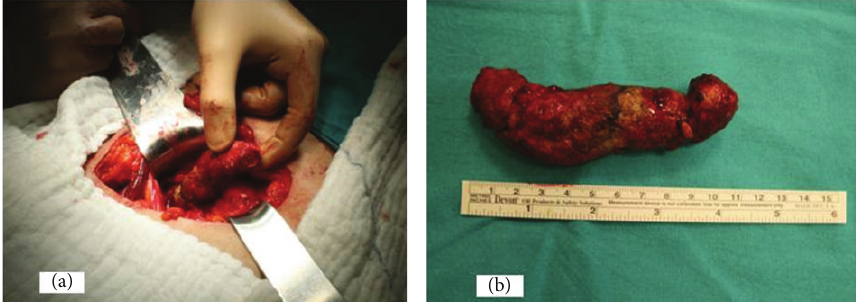
Figure 2: Ureterolithotomy operation (a) and removed giant ureteral stone